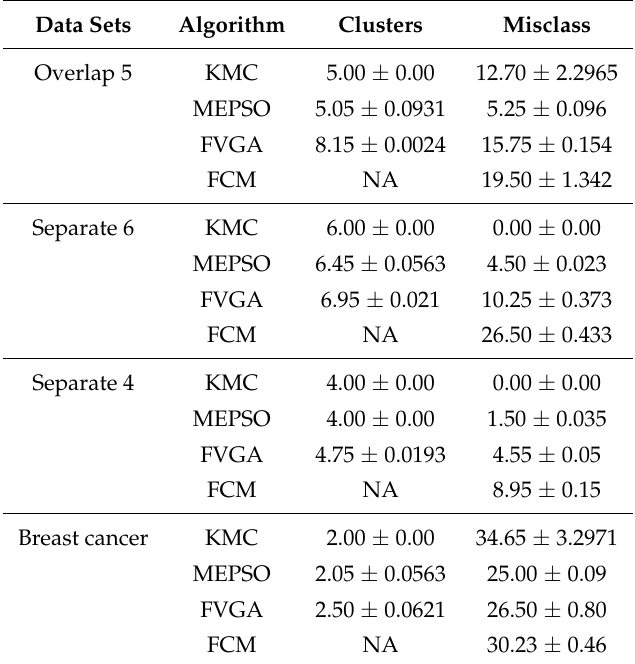
Table 3. Performance of FCM, FVGA, MEPSO and